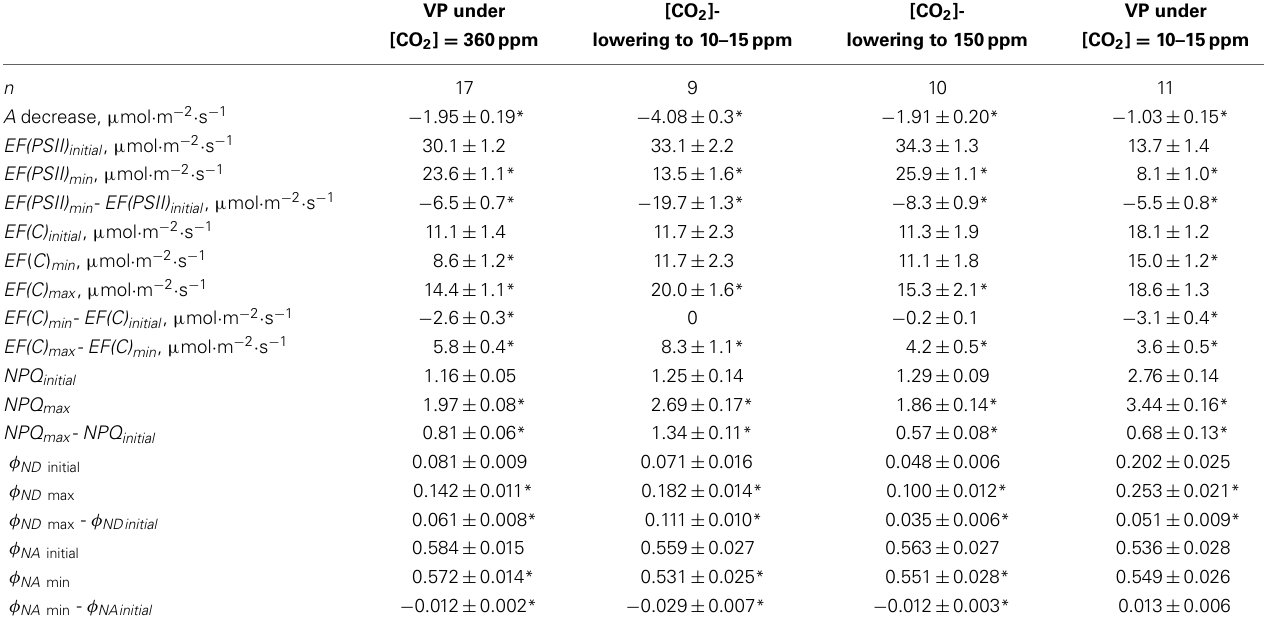
Table 1 | Photosynthetic parameters and changes induced by VP and [CO 2